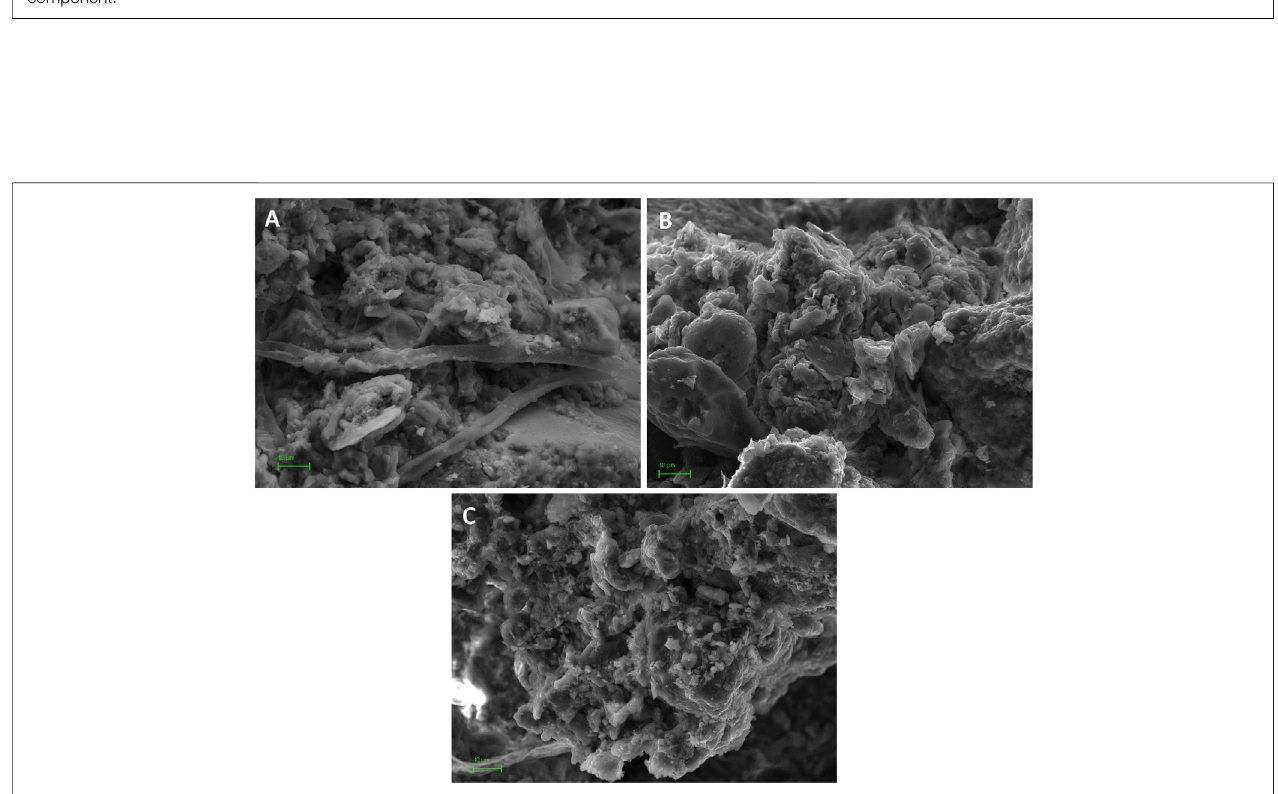
FIGURE 6 | SEM images of soil structure at colloidal scale. (A) forest sample (6300x): clay domains and clusters supported by fi lamentous structures of fungus hypha; (B) organic sample (6300x); (C) conventional sample (5700x). Scale bar = 10 μ m.